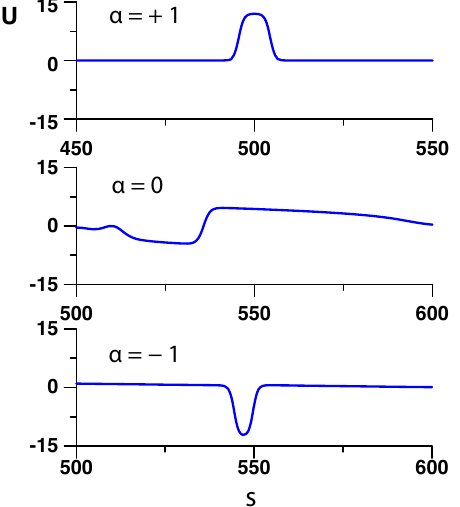
Fig. 4. Numerical simulation of the evKdV equation (6) with δ = 1, β = − 0 . 083 and as α varies from 1 to − 1. The upper panel shows the initial condition of a “table-top” solitary wave of elevation at α =− 1, the middle panel shows a strong deformation at α = 0, and the lower panel shows the leading wave at α = − 1. This wave is a “table-top” wave of depression riding on a small positive pedestal.